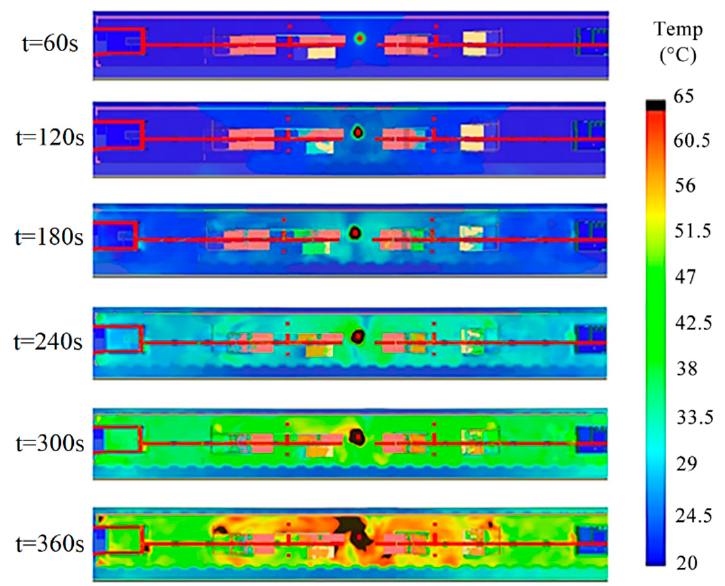
Figure 11. Fire smoke temperature in the middle of the platform.